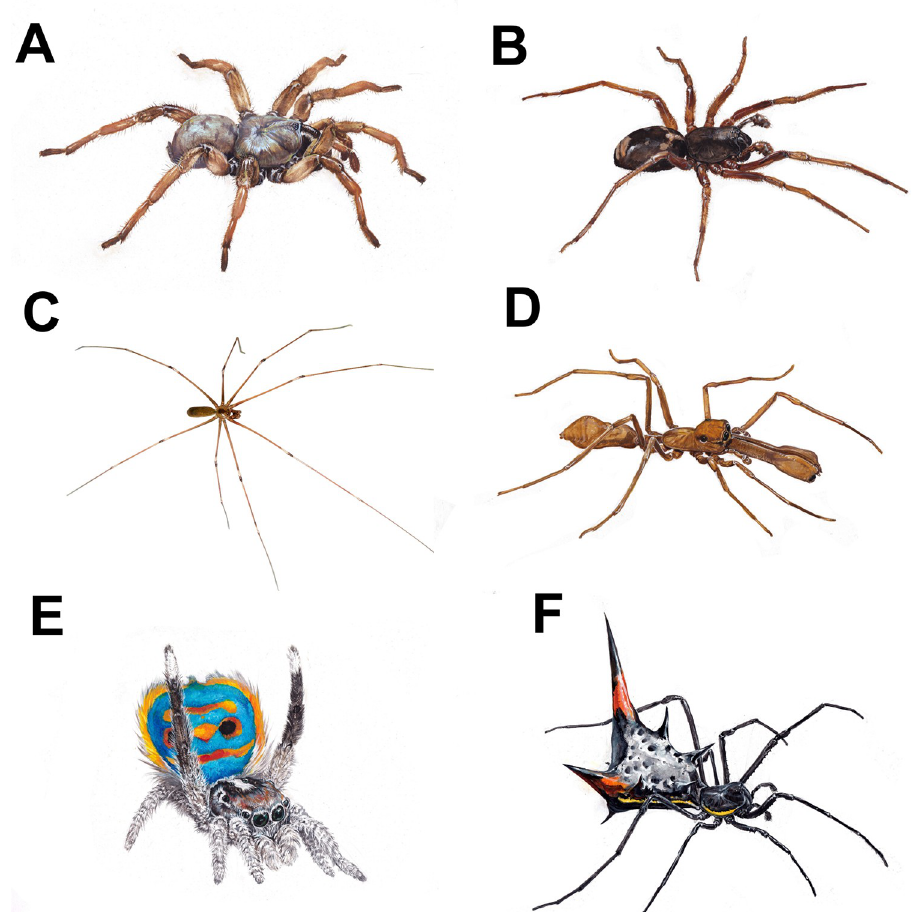
phalangioides (C), Myrmaplata plataleoides (D), Maratus speciosus (E), and Micrathena schreibersi (F). Authors: A-B, D-F–MVDr. Pavel Procha´zka; C–David